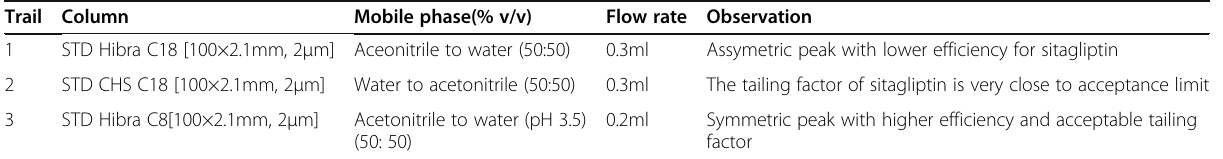
Table 1 Different trails Trail Column